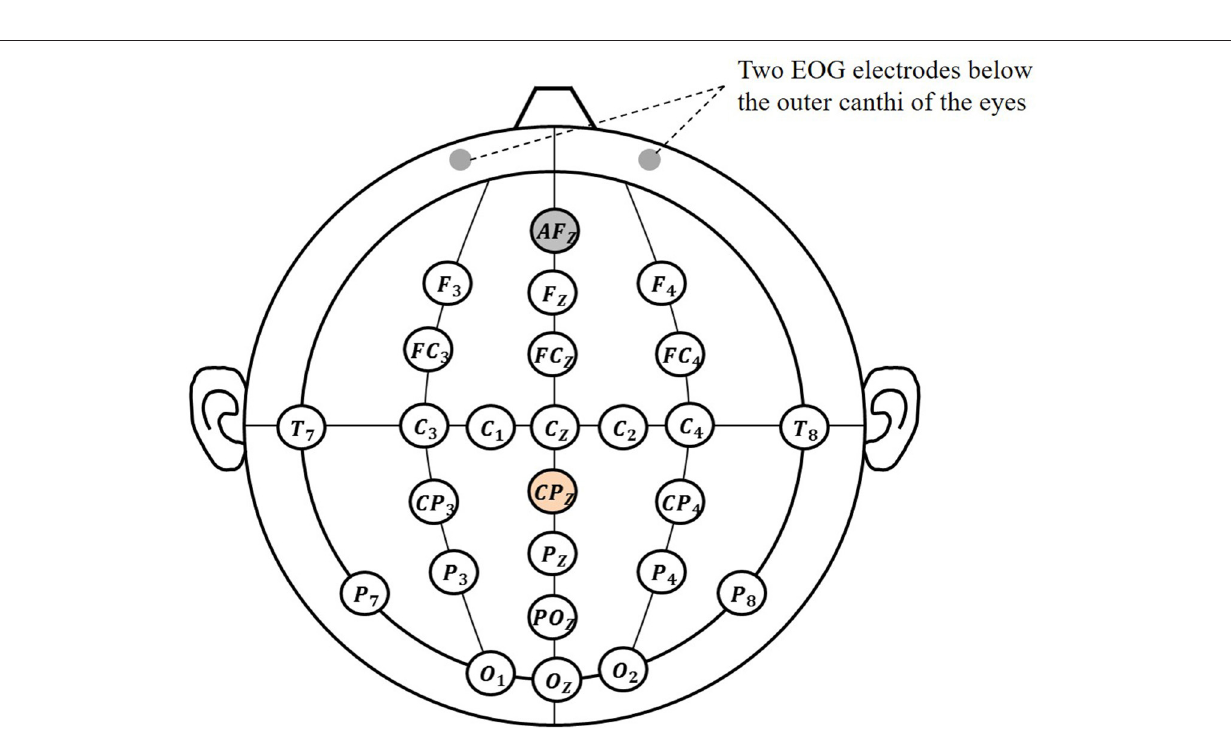
FIGURE 2 | Used electrodes position